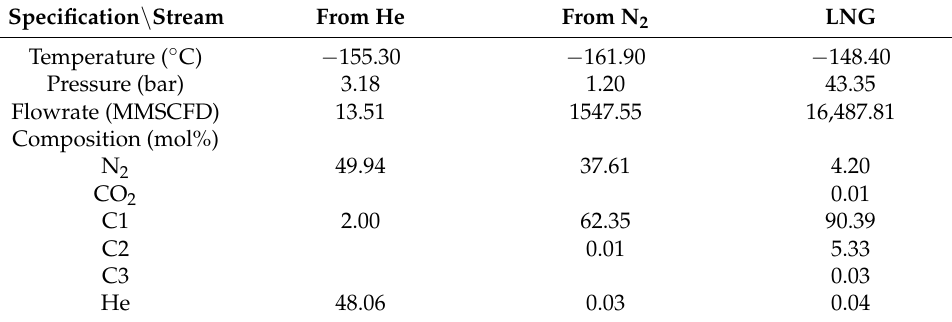
Table 8. NG liquefaction unit conditions and specifications.